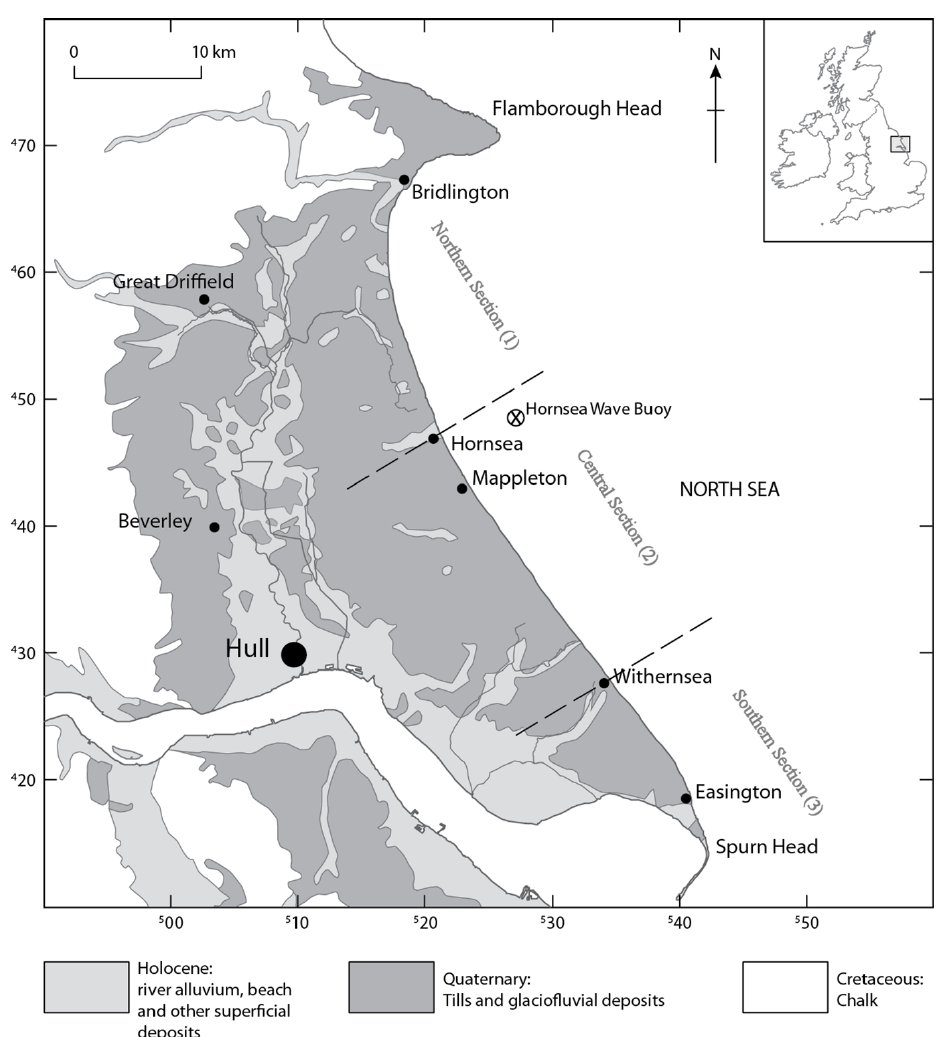
Figure 1. Geological composition of the Holderness coast (main) and the location of the region within the UK (insert). Also indicated are the positions of the Hornsea wave buoy, from which wave climate was recorded, and the division into northern, central and southern coastline regions, as referenced by the sea walls at Hornsea and Withernsea (dashed lines), to aid analysis. Modified from Barkwith et al. (2014).